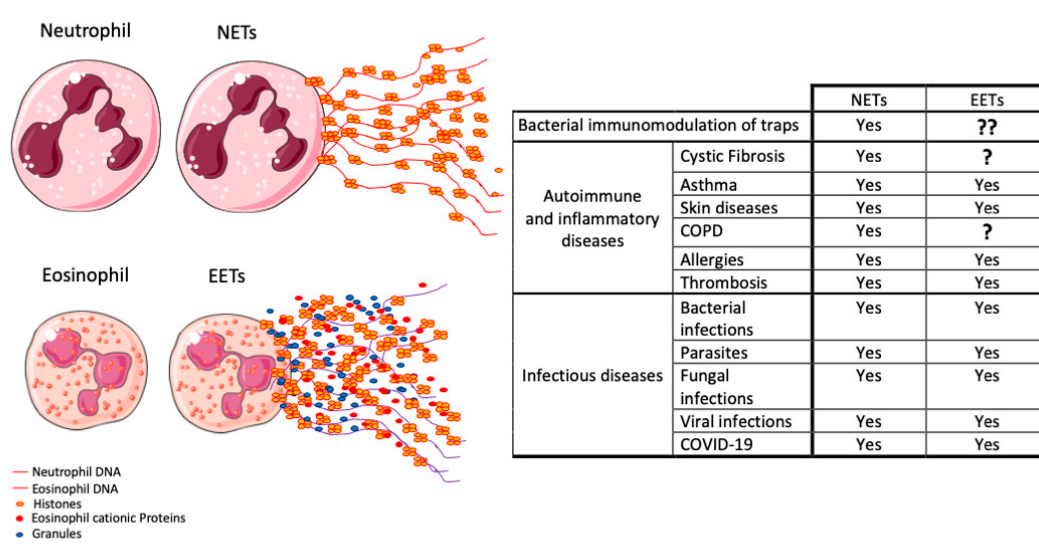
Figure 1. Involvement of NETs and EETs in diseases. The figure compares neutrophils and eosinophils as well as the extracellular traps they form. The right-hand side table summarizes autoimmune, autoinflammatory, and infectious diseases associated with the formation of NETs or EETs. The table also includes the ability of bacteria to modulate extracellular traps